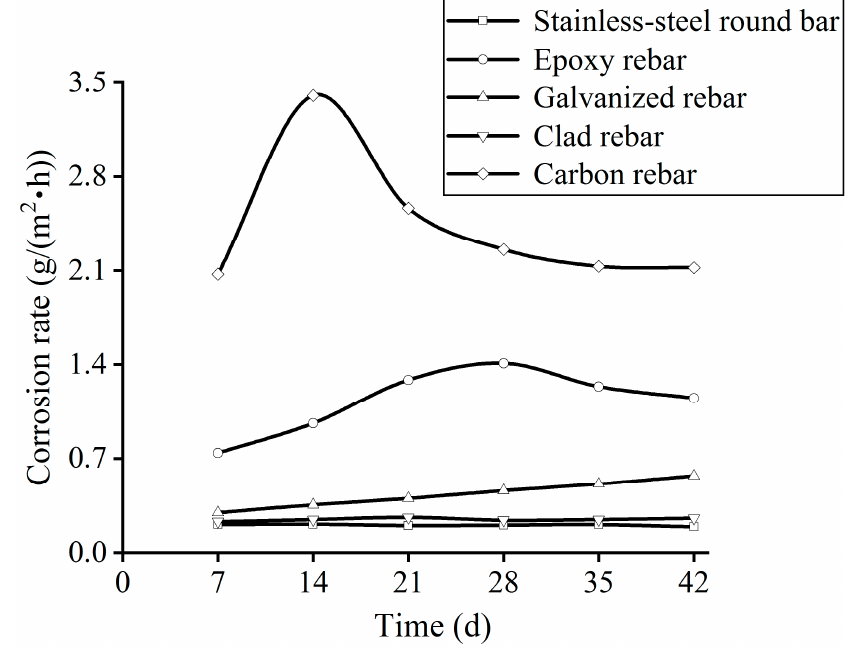
Figure 21. Corrosion rate variation curves the rebars.